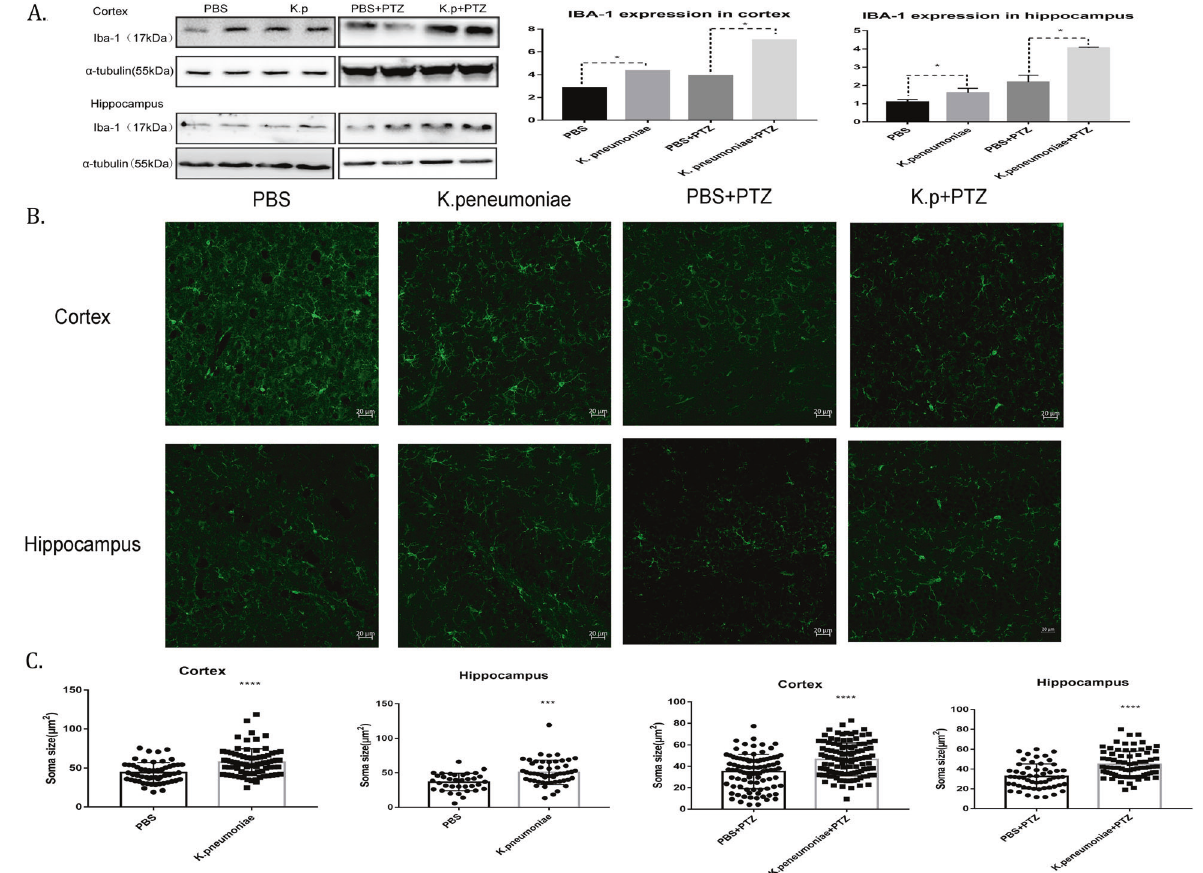
Fig. 3 K. pneumoniae activates microglia in mice. A Representative images of Iba-1 expression in the cortex and hippocaumps before and after the PTZ test. Compared with that in the controls, Iba-1 expression was consistently increased in the cortexes and hippocaumps of mice who were administered K. pneumoniae via gavage in two groups ( n = 3 in each group; * P < 0.05 versus controls, Student ’ s t test). B , C Representative confocal images of microglia; cell body changes in the cortexes and hippocampi of mice on the 14th and 29th days and a summary of the results (PBS, cortex, n = 57; K. pneumoniae , cortex, n = 78; PBS + PTZ, cortex, n = 93; K. p + PTZ, cortex, n = 114; PBS, hippocampus, n = 35; K. pneumoniae , hippocampus, n = 53; PBS + PTZ, hippocampus, n = 56; K. p + PTZ, hippocampus, n = 76; *** P < 0.001, **** P < 0.0001, Student ’ s t